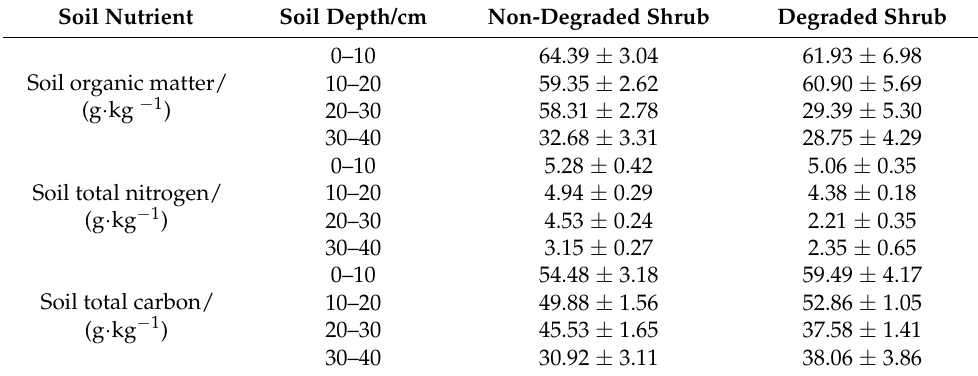
Table 2. The soil characteristics of alpine shrub meadow in this